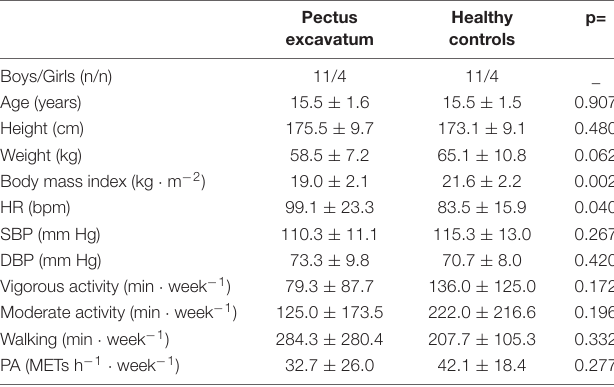
TABLE 1 | Demographic characteristics and biometric data of study participants.